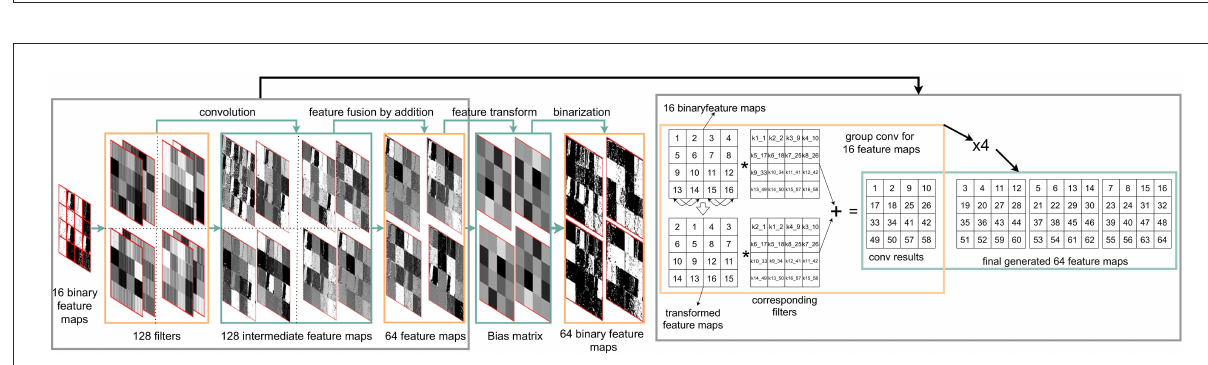
FIGURE9 An overview of an on-sensor FCN inference process within the PPA for object localization. The first convolutional layer uses the same convolution module with CNN in Figure 5. As for the second convolutional layer, 128 convolutional kernel filters are applied on 16 input binary feature maps, generating 64 feature maps with a convolution group setup of eight. The fusion of intermediate extracted features is implemented by addition within each group. The third layer uses binary filters with a size of 64 × 1 × 1, hence the final feature maps can be obtained by ‘multiplication’ with bit operation based on DREG. The final heat map is generated by fusing these input 64 binary feature maps by only shifting and addition operations. More details on group convolution implementation can be seen in Supplementary Figure